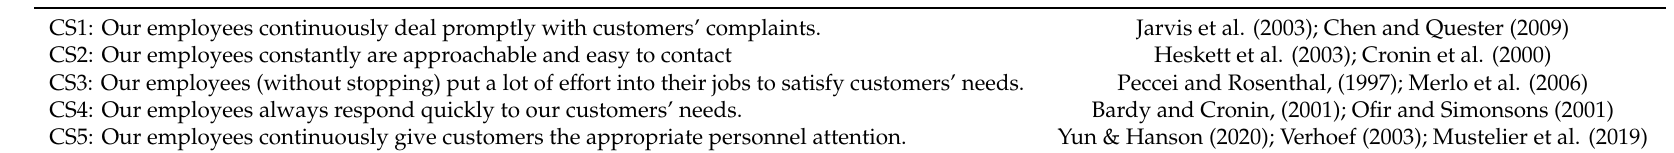
Table A4. Modified perceived sustainable customer